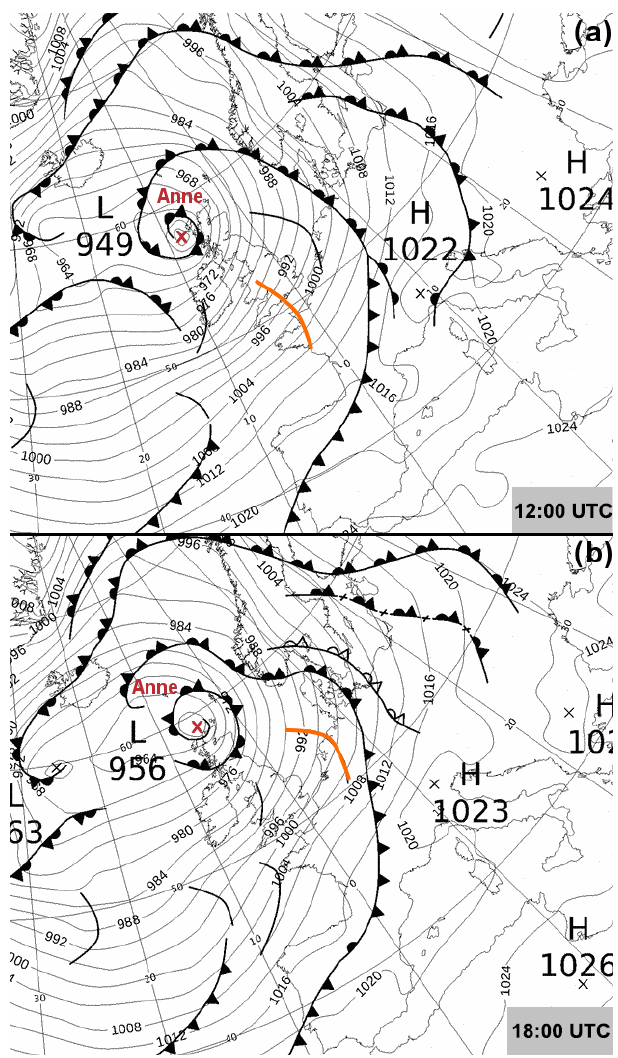
Figure 3. Surface weather chart of mean sea level pressure (hPa), fronts and surface troughs at (a) 12:00UTC and (b) 18:00UTC on 3 January 2014 (source: UK Met Office). The surface trough as- sociated with the development of the derecho-producing mesoscale convective system is denoted by the orange